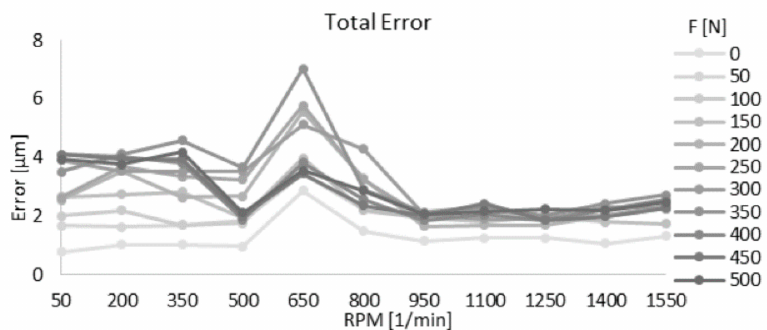
Figure 63. Graph of resulting total error based on spindle speed and load